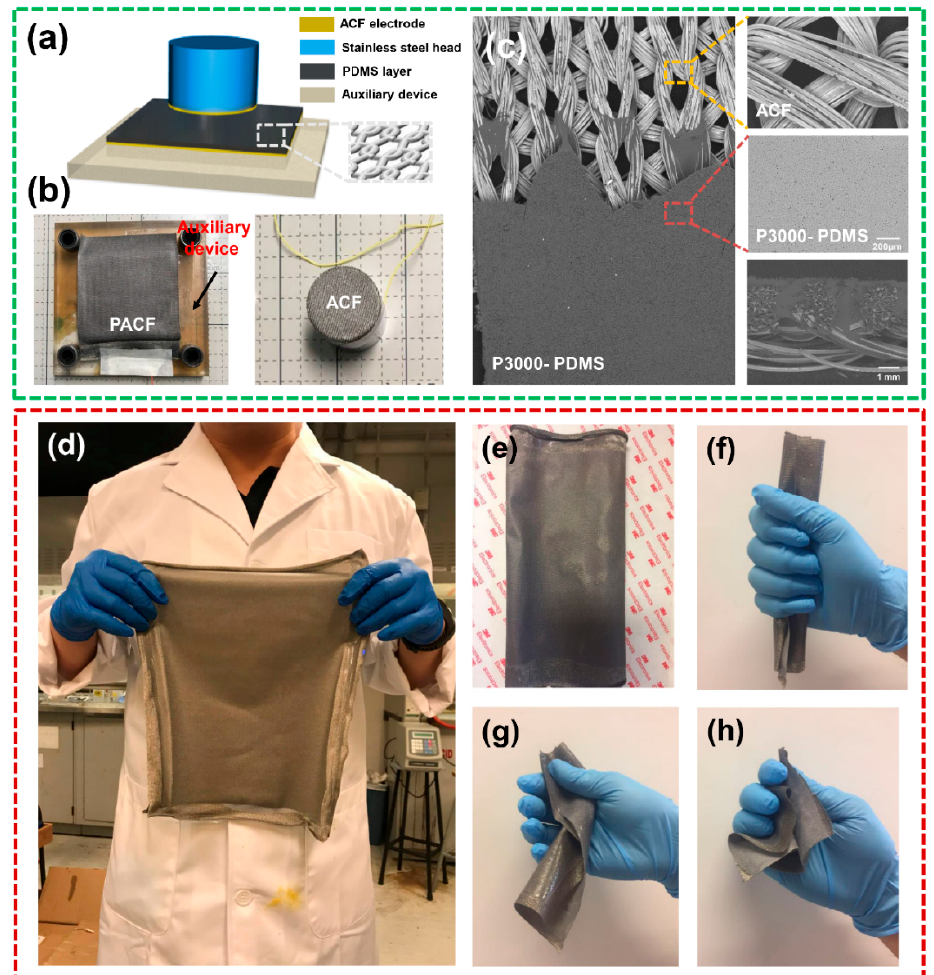
Figure 2. ( a , b ) Schematic and practical images of T-TENG assisted by an auxiliary device. ( c ) SEM image of PACF composite film, inset ACF electrode, surface microstructure of PDMS and cross-sectional SEM image of PACF. ( d ) Ultra-flexible and large-scale PACF composite film. ( e – h ) Images of PACF in cases of being compressed, warped and folded.